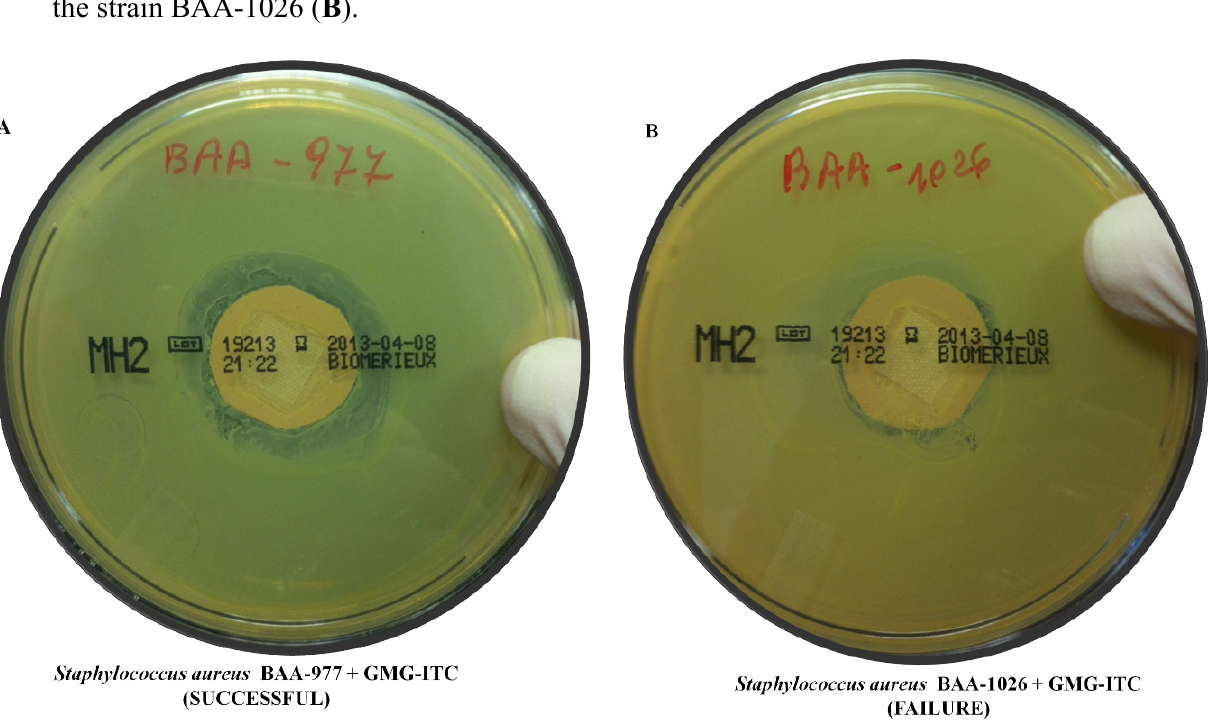
Figure 1. Antibiogram to assess S. aureus sensibility to GMG-ITC treatment. To verify the sensibility of S. aureus to GMG-ITC, BAA-977 strain and BAA-1026 strain were incubated for 24 h with the antibiotic according to a disk-diffusion method. Results indicate that GMG-ITC inhibits the bacterial growth of BAA-977 strain ( A ), with an inhibition halo of about 25 ± 1 mm, but it was not able to counteract the bacterial growth of the strain BAA-1026 ( B